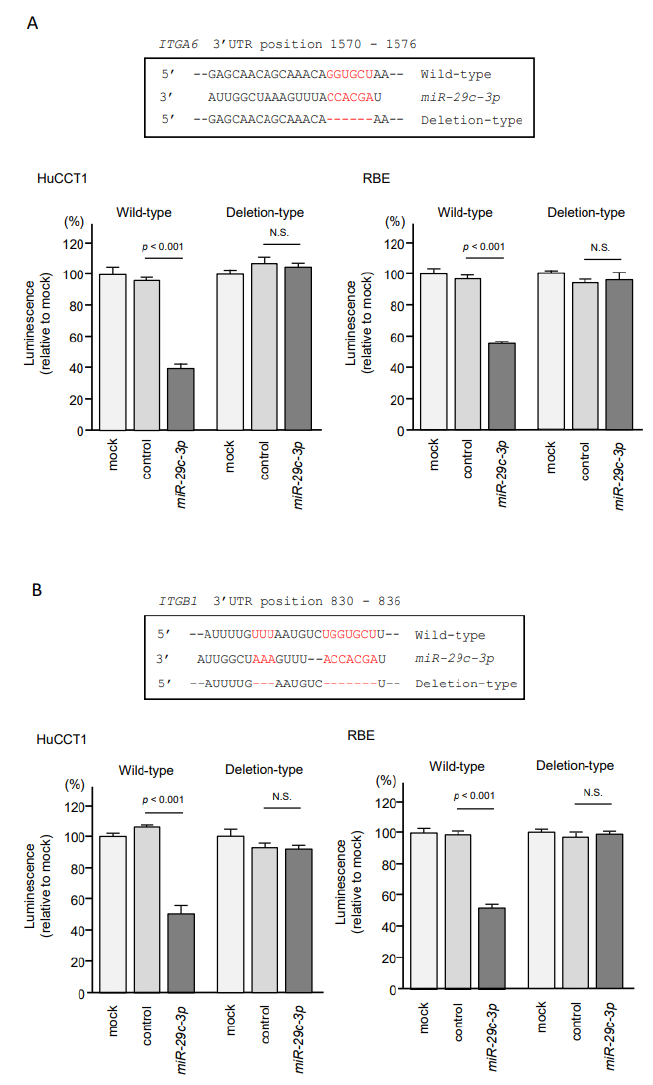
Figure 7. Direct regulation of ITGA6 and ITGB1 expression by miR-29-3p in ICC cells. ( A ) Dual- luciferase reporter assays showed that luminescence activity was reduced by co-transfection with wild-type vector (containing the miR-29-3p binding site of ITGA6 ) and m iR-29c-3p precursor in HuCCT1 and RBE cells. In contrast, no change of luminescence activity occurred after co-transfection with deletion-type vector luciferase activity with miR-29- 3p transfection into ICC cells. Normalized data were calculated as the ratios of Renilla /firefly. ( B ) The luminescence activity was reduced by co-transfection with wild-type vector (containing miR-29-3p binding site of ITGB1 ) and m iR-29c-3p precursor in HuCCT1 and RBE cells. In contrast, no change of luminescence activity occurred after co-transfection with deletion-type vector luciferase activity.